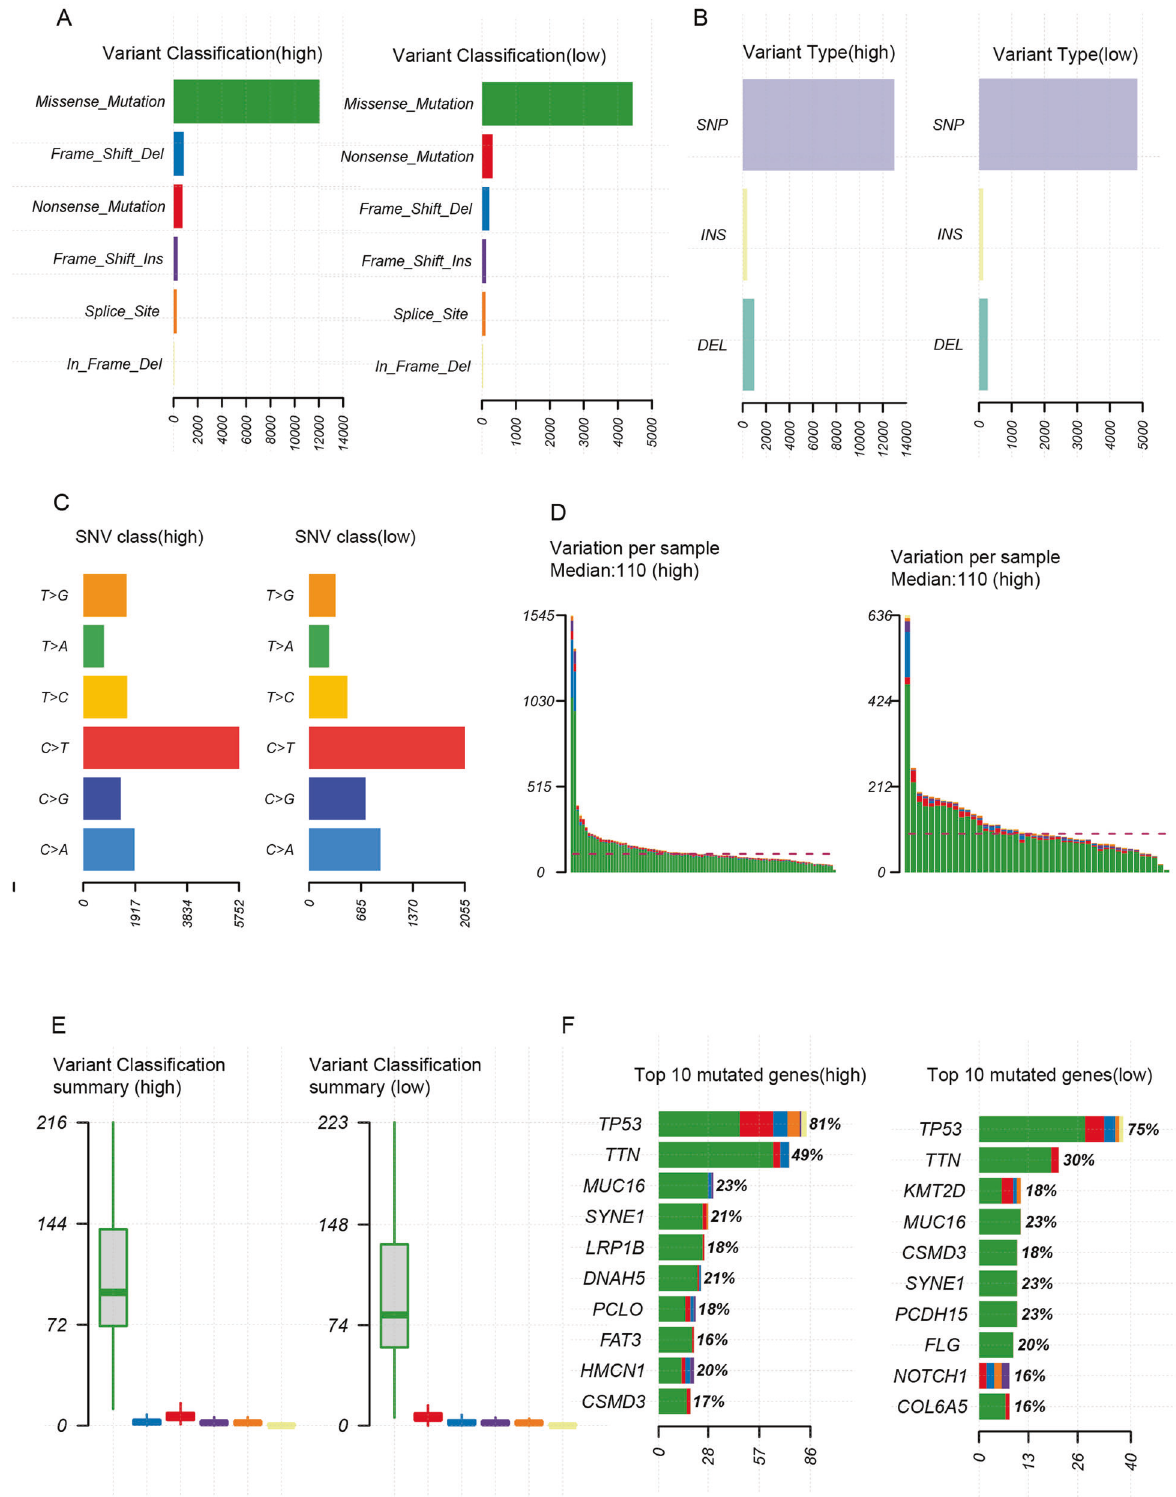
Fig. 6 Higher CRGs score patients held a higher mutation loading. A Variant classi fi cation graph between high-CRGs score group and low- CRGs score group. B Variant type graph between high-CRGs score group and low-CRGs score group. C SNV class graph between high-CRGs score group and low-CRGs score group. D Variation per sample between high-CRGs score group and low-CRGs score group. E Variant classi fi cation summary graph between high-CRGs score group and low-CRGs score group. F Top 10 mutated genes between high-CRGs score group and low-CRGs score